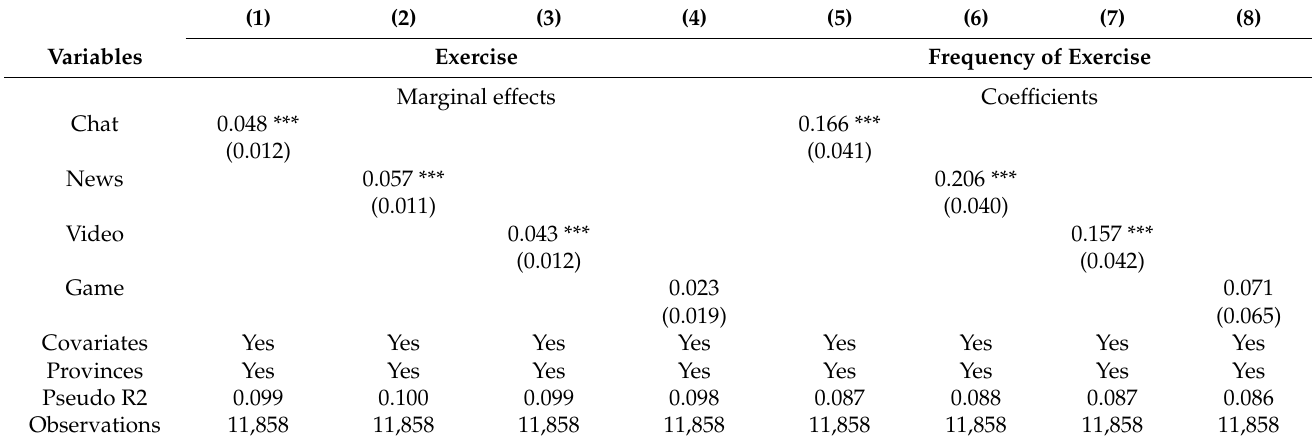
Table 3. Regression results of the association between Internet-use purpose and physical exercise.